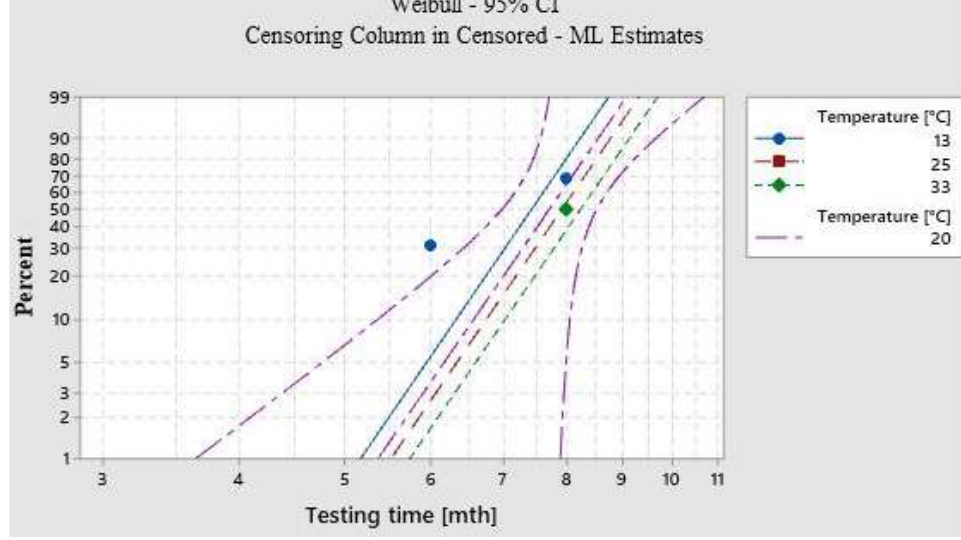
Figure 2. Probability plot (Fitted Arrhenius) for a testing time in months [mth]. Table 3. The results obtained for the estimated time until the failure of the samples. Expected Durability [mth] Unchanged Samples Time until [%] Degradation [mth] Lower Limit Upper